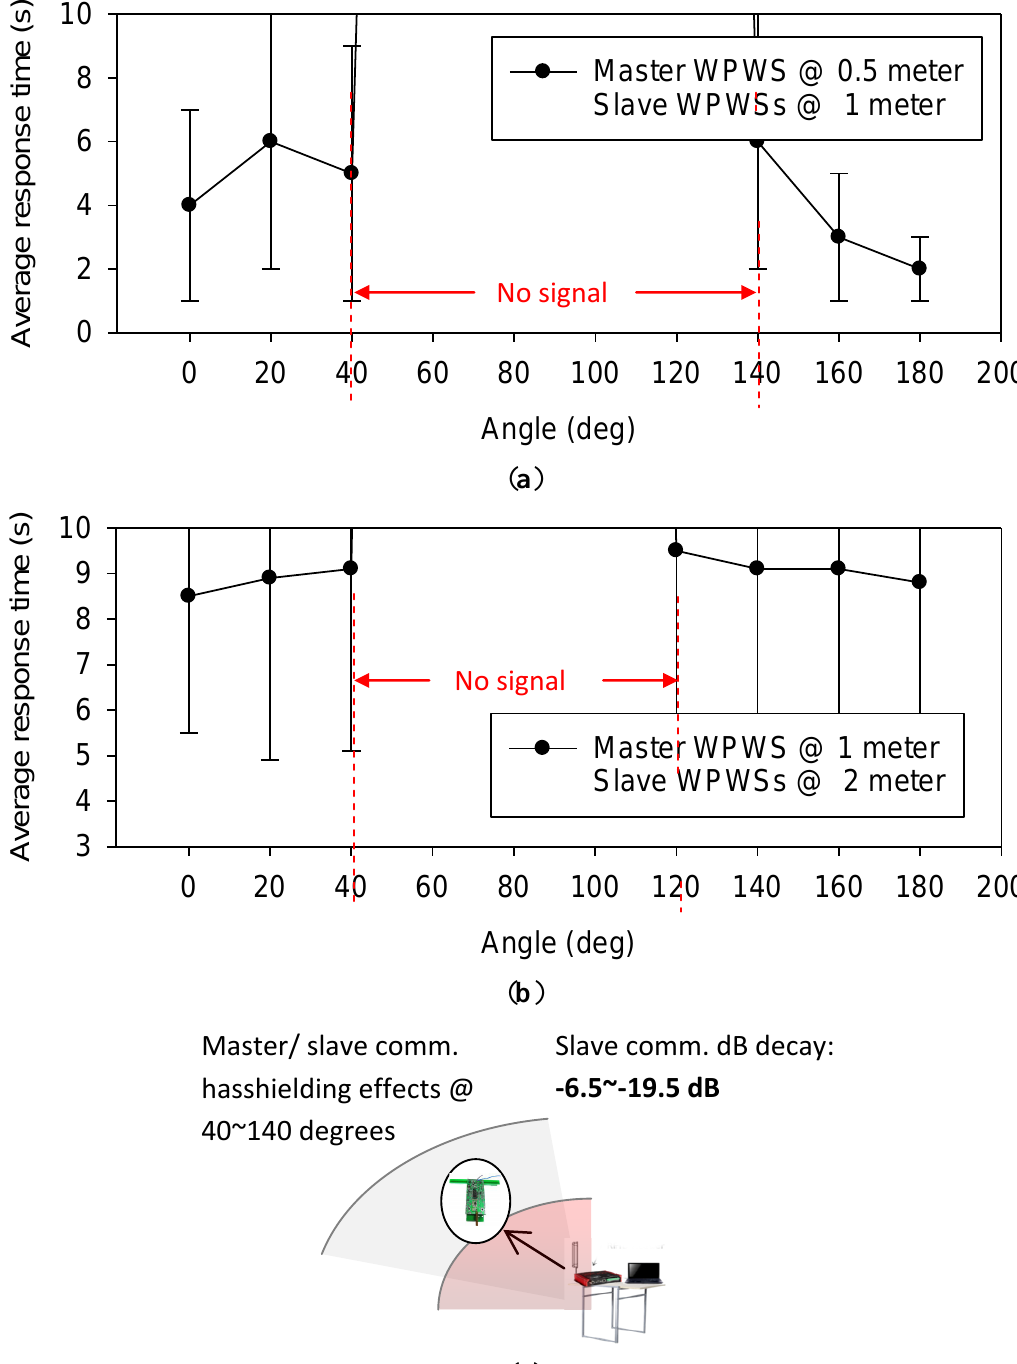
Figure 24. The WPWSs can form a star topology to construct a sensor network. The average response time of one master WPWS located at 0.5 m and 1 m and 11 WPWSs distributed at 1 m and 2 m diameter area appear in ( a ) and ( b ). The dB decay with and without master WPWS appears in ( c